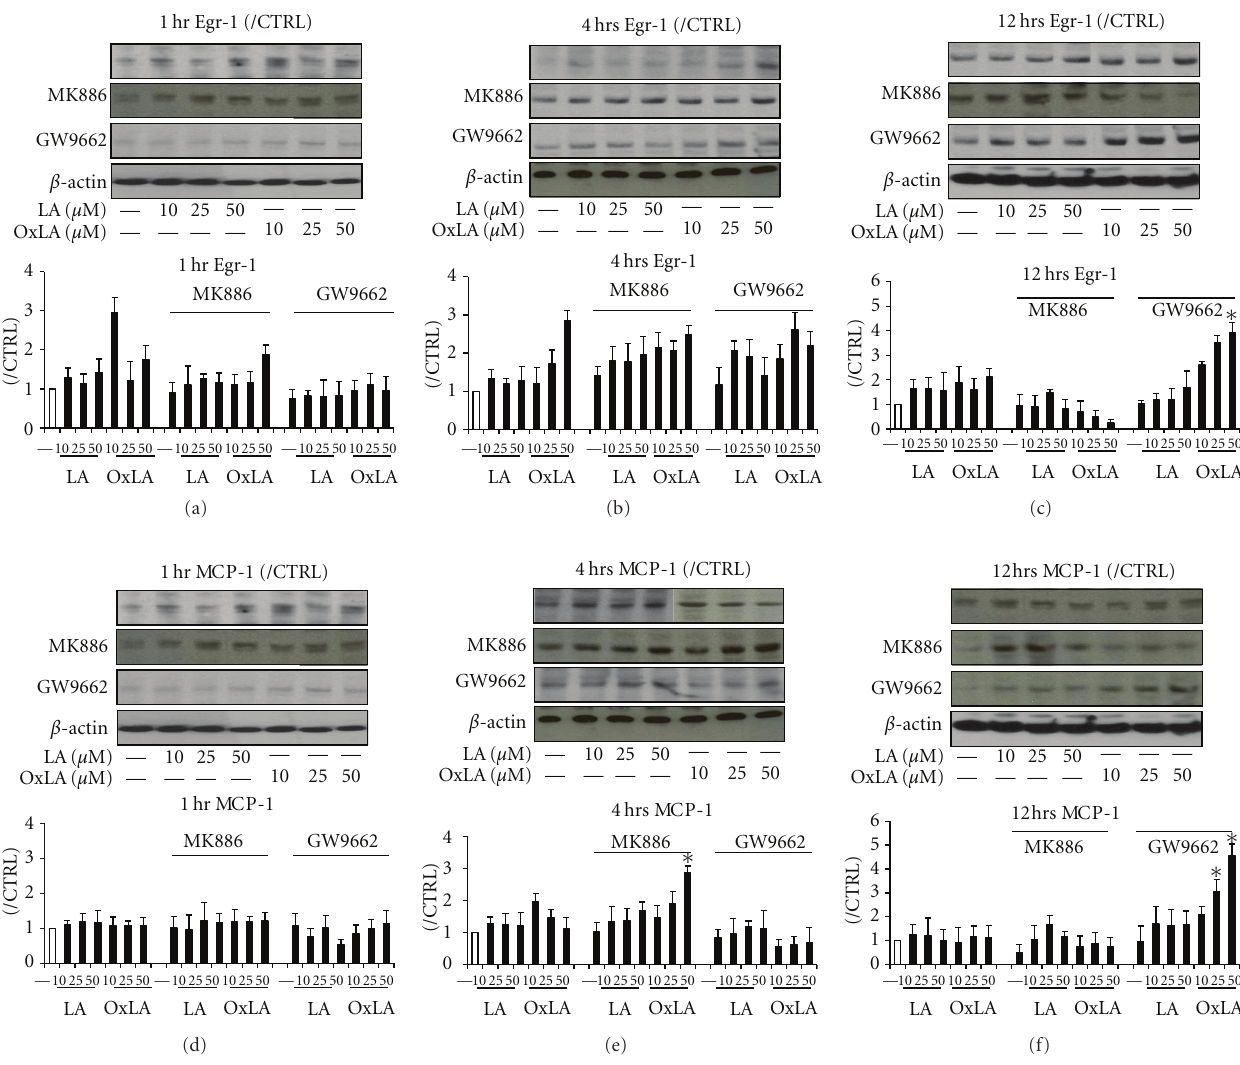
Figure 3: PPAR mediated alteration in Egr-1/MCP-1 protein levels by ω -6 lipids. Egr-1 and MCP-1 protein levels were determined using Western blot in cells exposed to ω -6 lipids after pretreatment with PPAR α or γ antagonists, MK886 or GW9662. Control-(CTRL) vehicle only. The results were expressed as mean ± SEM (Standard Error of Mean). (a–c) Egr-1 protein levels after 1, 4, and 12 hrs; (d–f) MCP-1 protein levels after 1, 4, and 12 hrs. One way ANOVA was used for the comparison between two treatments. Significance was confirmed using post hoc Fisher LSD test. ∗ P < 0 .